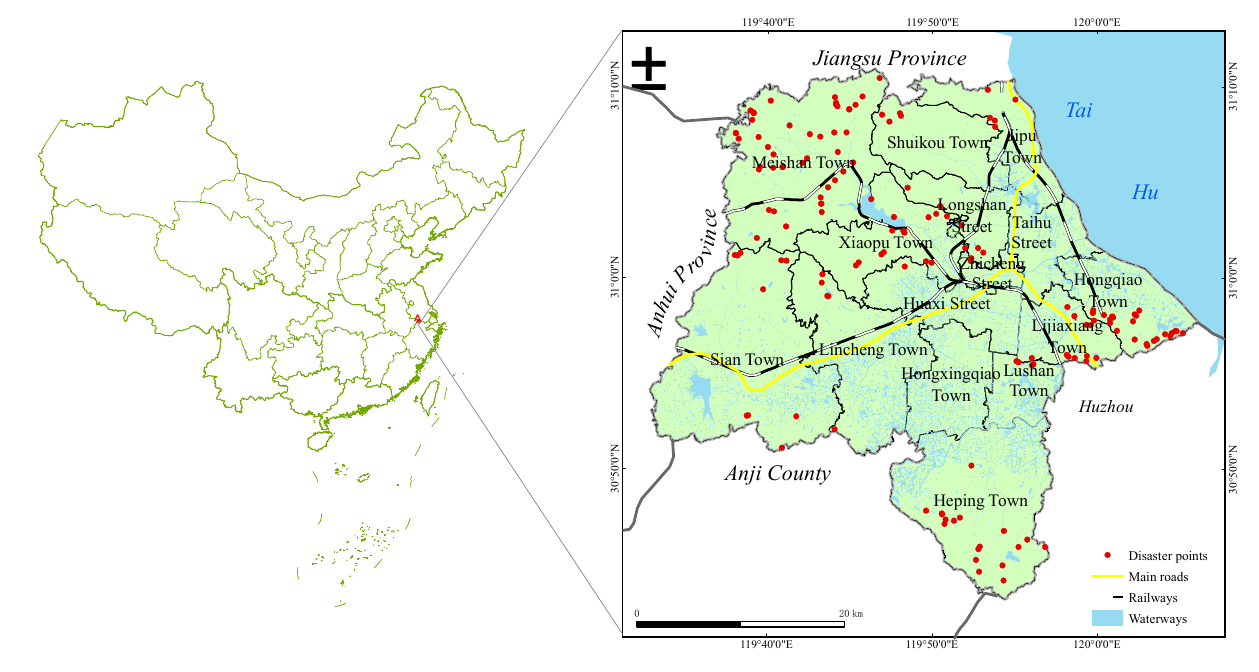
Figure 1. Geographical location and distribution of disaster points in Changxing County, Zhejiang Province.